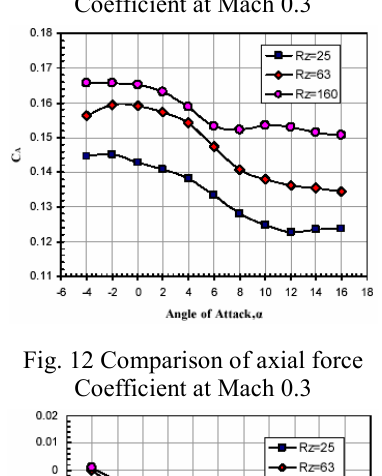
Fig. 11 Comparison of normal force Coefficient at Mach 0.3